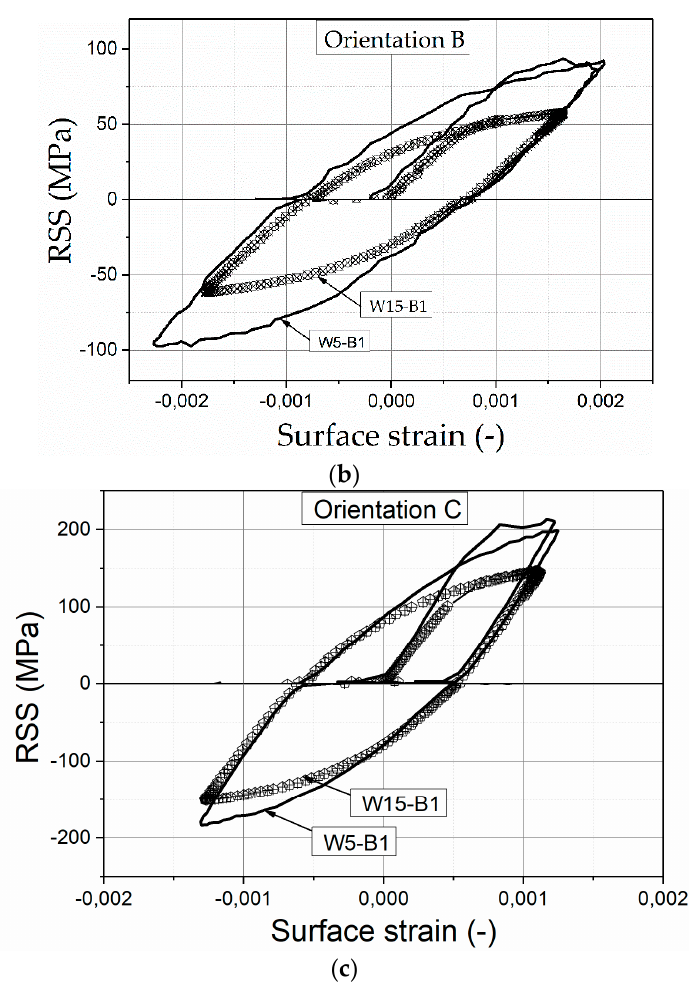
Figure 2. Representative cyclic stress-strain curves for beams with a width of 15 and 5 µm (W15 and W5) oriented for ( a ) single slip, ( b ) critical double slip, and ( c ) coplanar double slip.